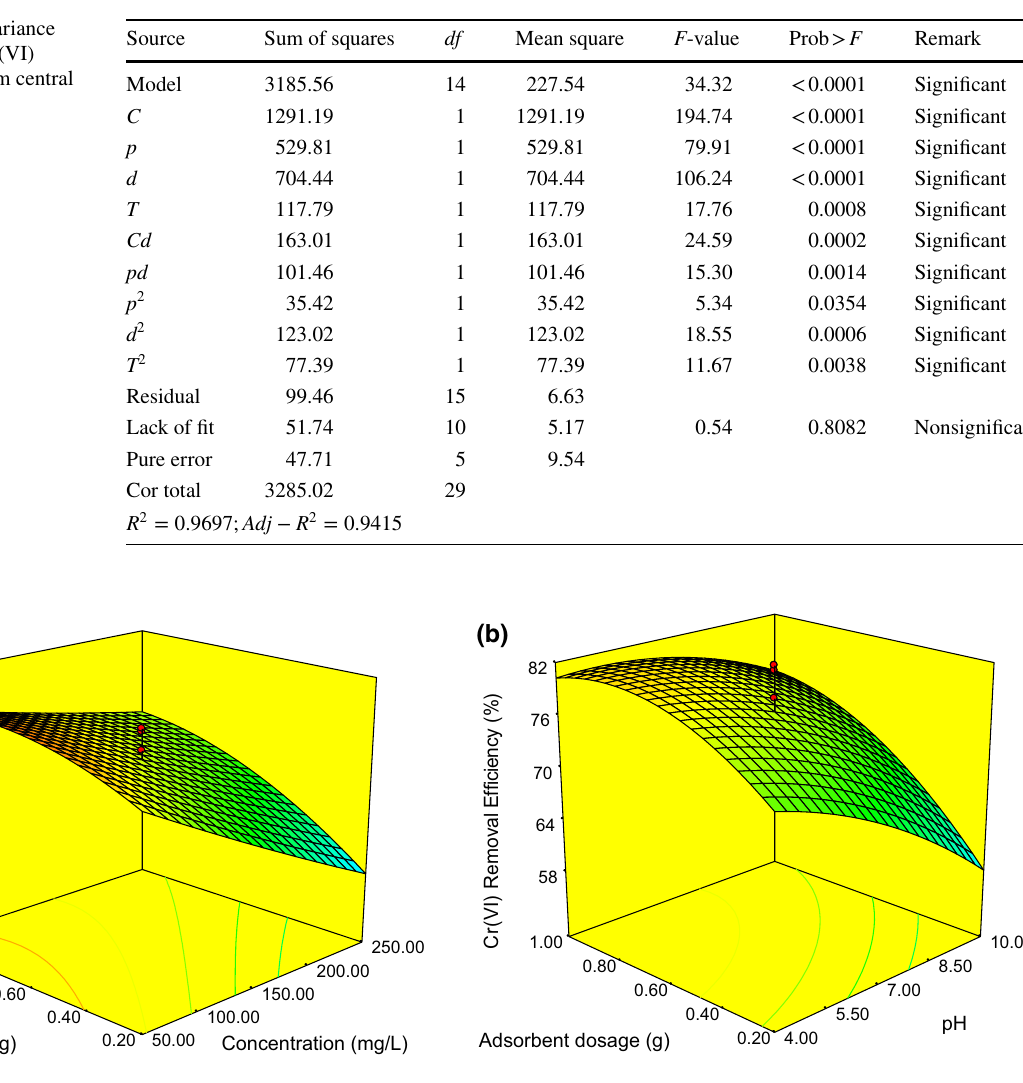
Fig. 5 Interactive effect of parameters on the removal efficiency of Cr(VI) a concentration versus adsorbent dosage and b pH versus